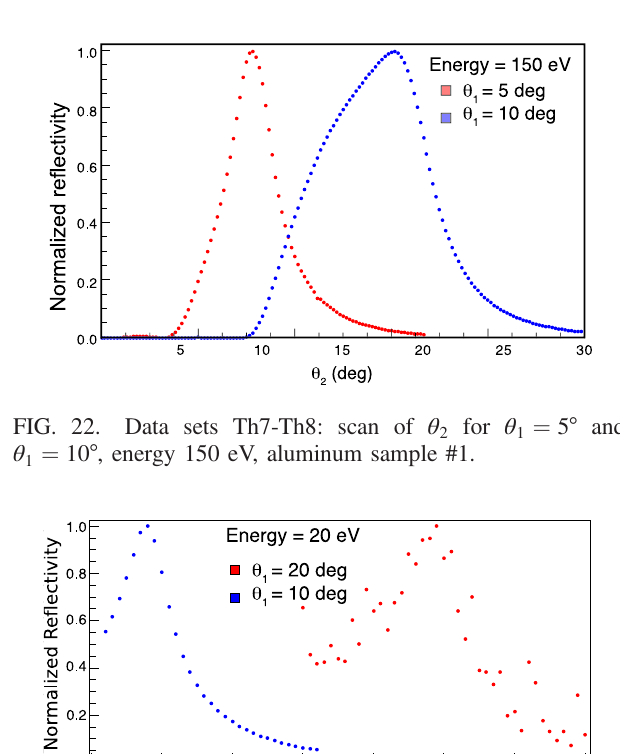
FIG. 24. Data sets Ph1-Ph4: scan of out-of-plane angle for several energies, with fixed θ 1 ¼ 1 . 5 ° and θ 2 ¼ 2 . 6 °, aluminum sample #1. The relationship between θ and θ 1 is given in Sec. i